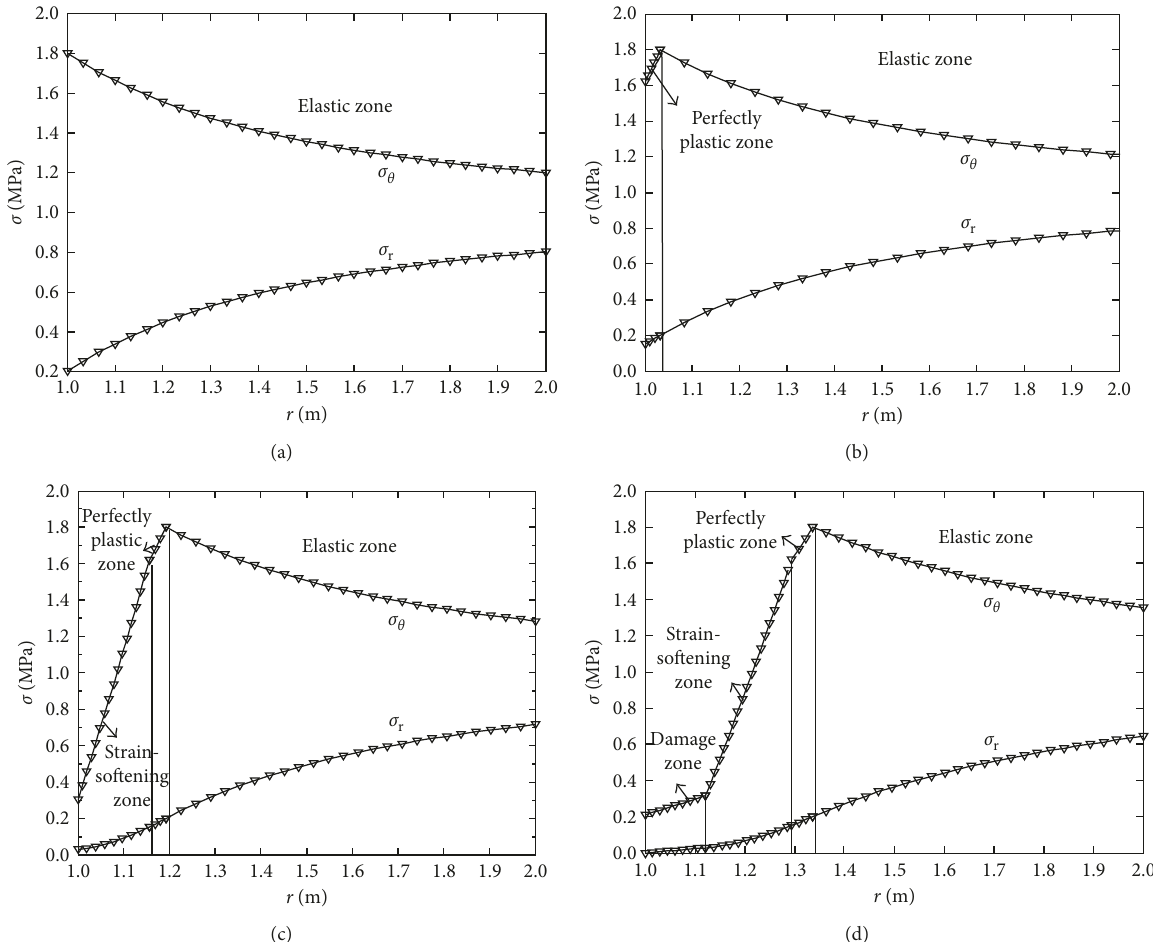
Figure 5: Stress distribution law of the EPSDM under different critical support resistance. Table 3: Critical support resistance ( p